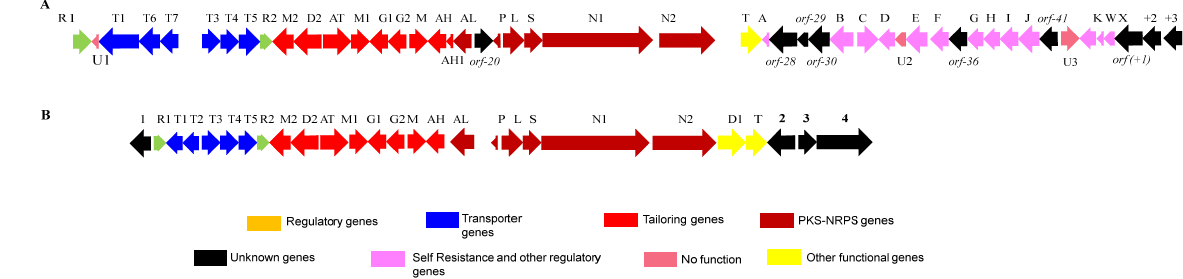
Figure 3. Genetic organization of the putative 2,2 ′‐ BP BGCs from S. griseus SCSIO PteL053 ( A ) and Streptomyces sp. CS40 ( B ). Table 2. Determined functions of ORFs in the cls